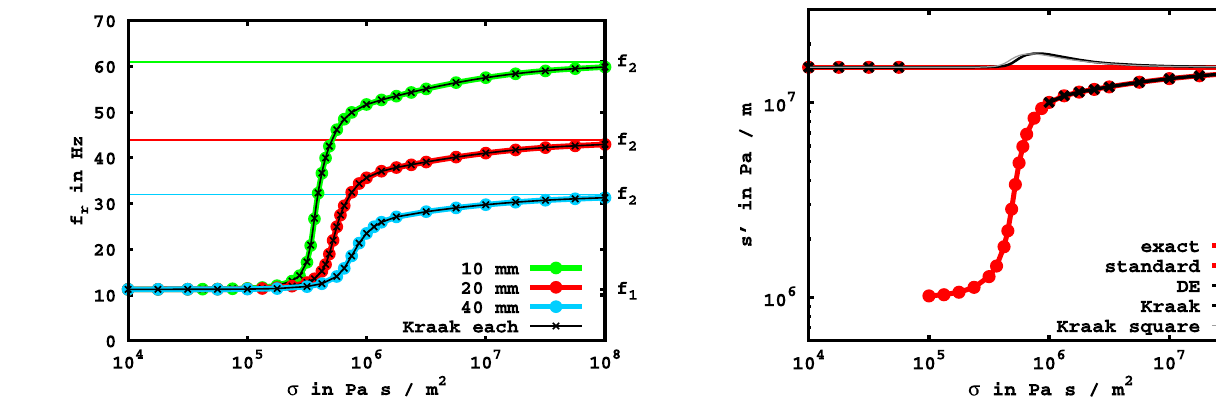
Figure 7. Resonance frequencies f r for different values of the thickness d according to the legend, Kraak ’ s respective solutions for comparison, lines for asymptotes at f 2 in according colors.